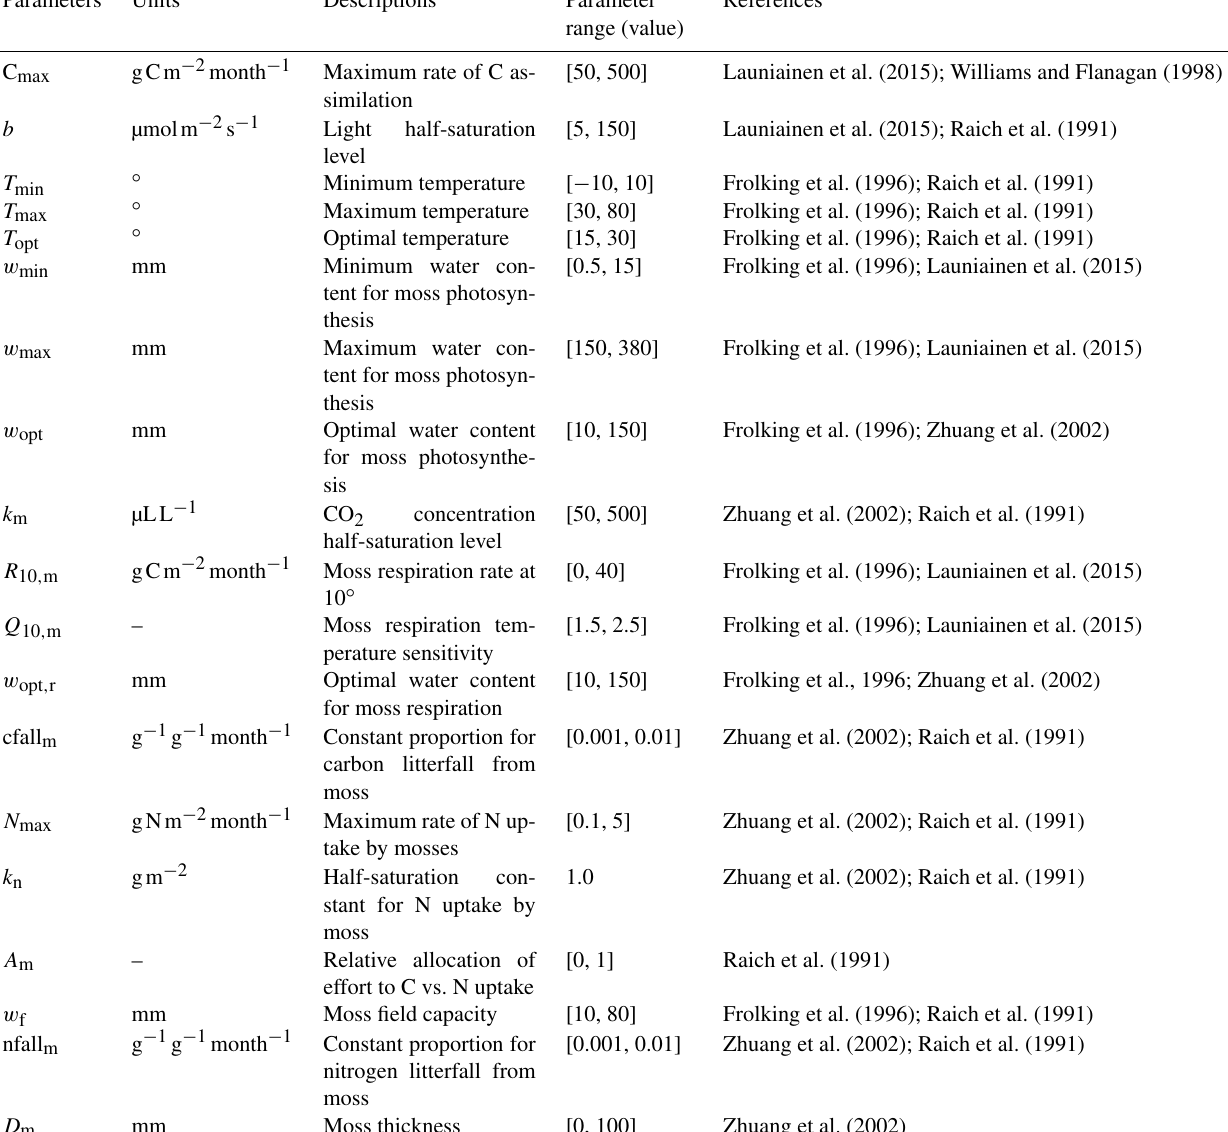
Table 1. Parameters associated with moss activities in TEM_Moss.